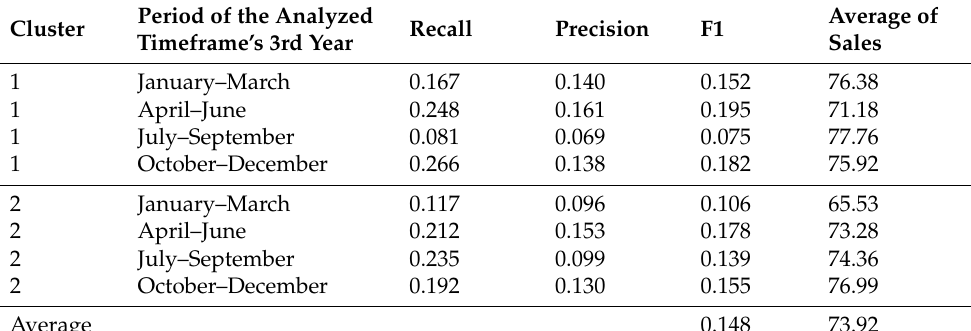
Table 8. Implementation outputs of the current recommendation